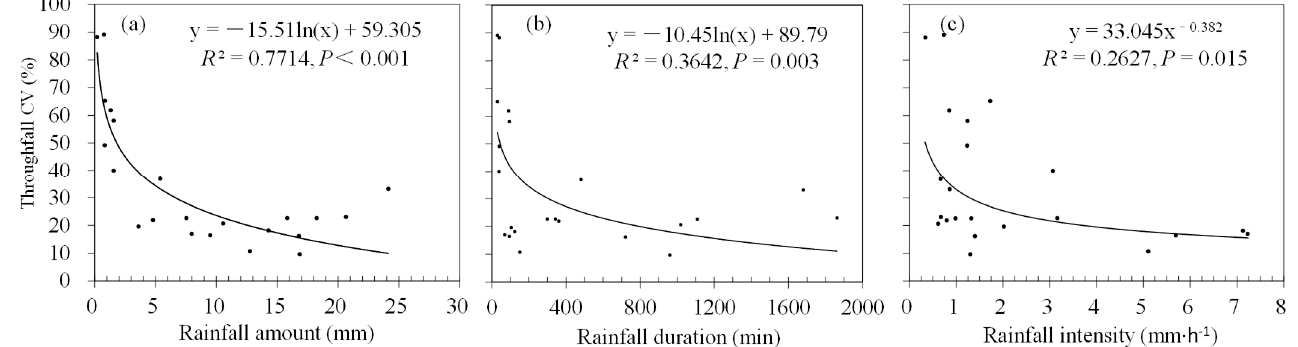
Figure 5. Coefficient of variation of throughfall (throughfall CV RP ) in relation to the rainfall amount ( a ), rainfall duration ( b ), and rainfall intensity ( c ).